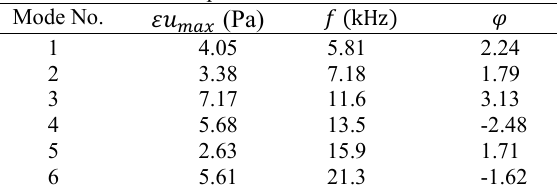
Table 1. AE model parameters in the simulations Mode No.